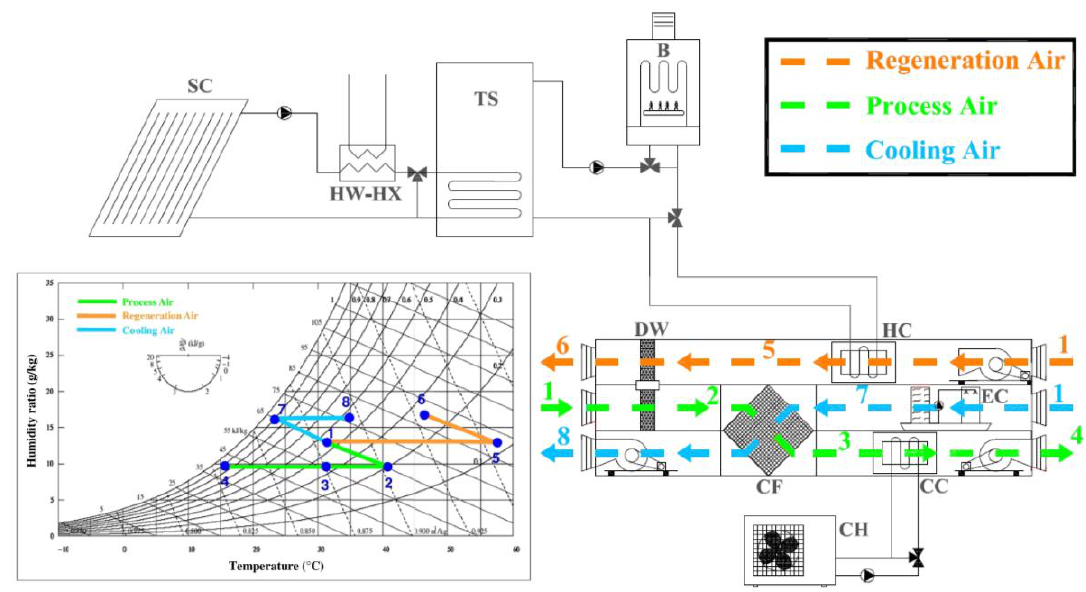
Figure 1. Scheme of the desiccant-based air handling unit (AHU) and psychrometric diagram (cooling mode, Scenario A).